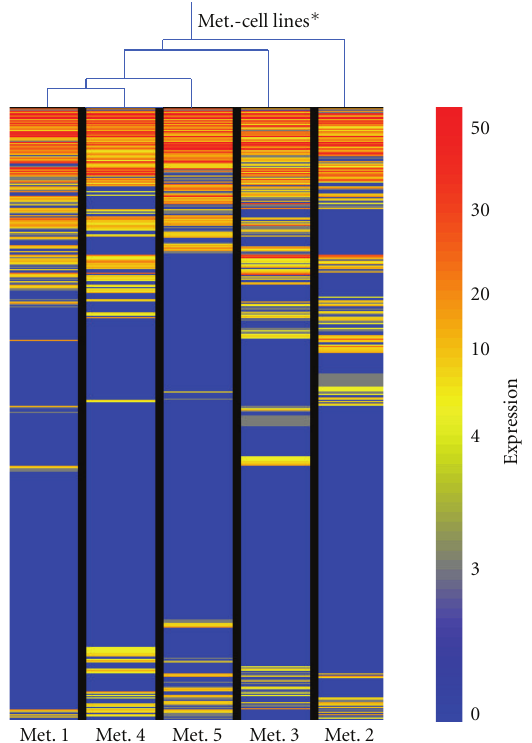
Figure 2: Hierarchical clustering analysis of the SAGE libraries, generated from the Met.-cell lines, using the standard correlation algorithms (GeneSpring). ∗ Cluster size ≥ 2.